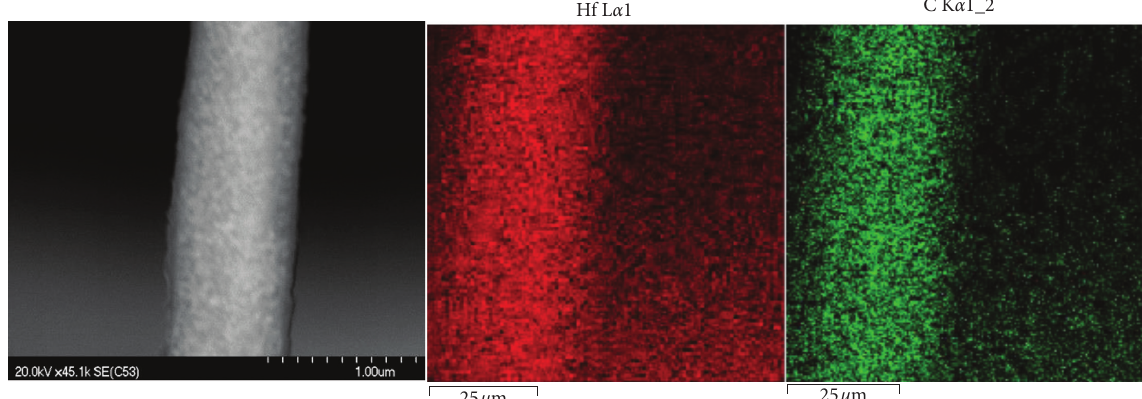
Figure 7: EDS analysis of as-spun HfC fibers after